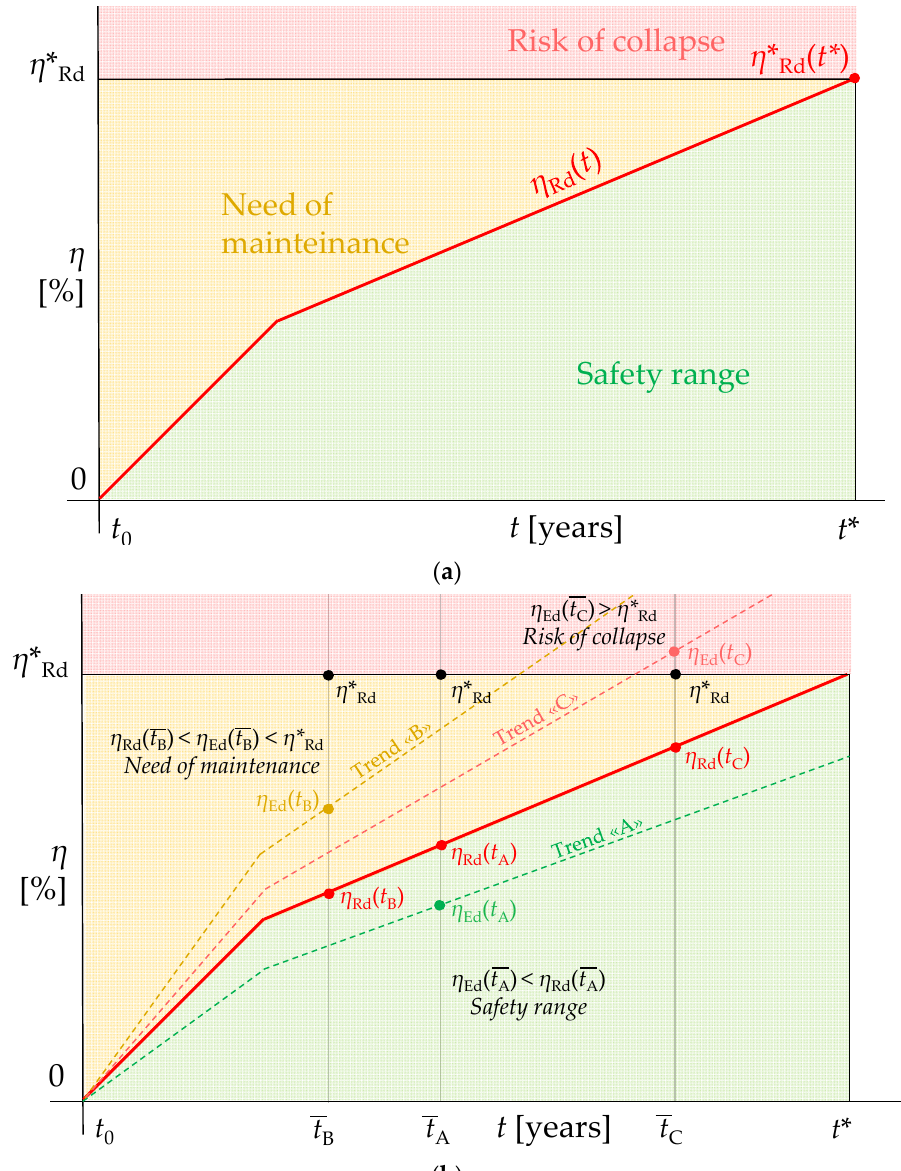
Figure 6. ( a ) Damage stages due to corrosion fatigue according to the presented methodological approach and ( b ) examples of fatigue check results for different corrosion trends and instants of assessment.